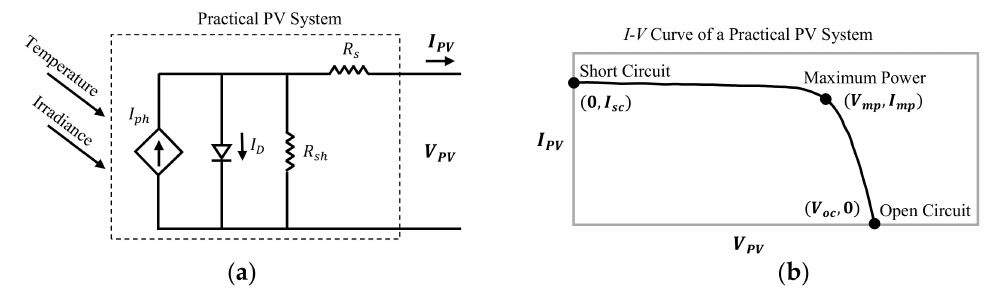
Figure 2. Modelling and characteristic of a practical PV array: ( a ) Single-diode model, ( b ) I–V curve. A PV array consists of N p parallel PV strings each including N s modules of PV connected in